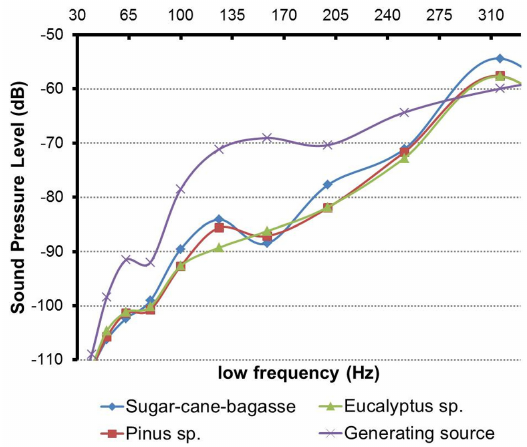
Figure 7. Sound pressure levels for low frequencies (0 - 500 Hz).